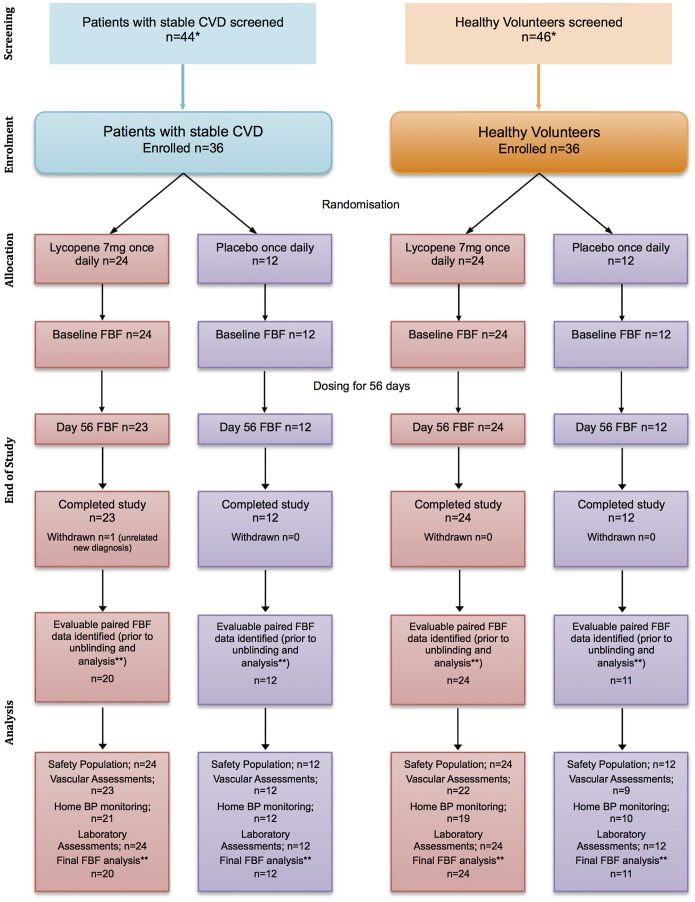
Flow diagram of subjects through the study.The safety population consisted of anyone who received at least 1*Reasons for failure to enrol included not meeting inclusion criteria, an inability to attend laboratory for assessments within the appropriate timeframe, patient withdrawal, inability to lie flat for a period of time for the studies, or an inability to cannulate the brachial artery. **Quality control evaluation done by two independent parties. Reasons for non-evaluable data and consequent exclusion from final forearm blood flow (FBF) analysis (before unblinding and statistical analysis) included incomplete data sets, non-evaluable sets, and FBF procedure variation.